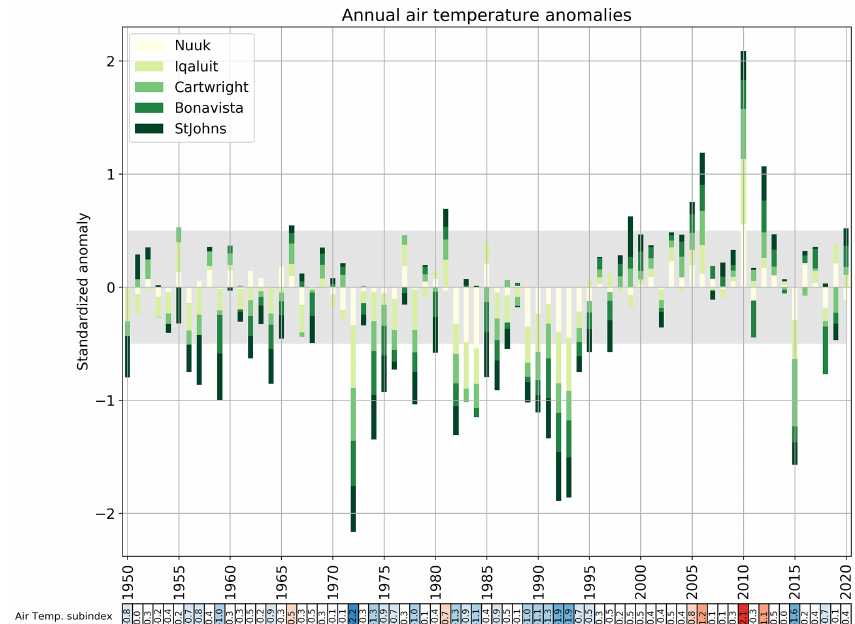
Figure 3. Normalized annual air temperature anomalies for Nuuk, Iqaluit, Cartwright, Bonavista and St. John’s. This figure shows the average of the five stations, in which the length of each bar corresponds to the relative contribution of the individual station to the average. The shaded area corresponds to the 1991–2020 average ± 0 . 5SD. The numerical values of this time series are reported in a colour-coded scorecard at the bottom of the figure. Positive anomalies ( > 0 . 5SD) are coloured red, while negative anomalies ( < − 0 . 5SD) are coloured blue. In both cases, the darker the colour, the stronger the anomaly. White corresponds to the climatological average ± 0 . 5SD. This time series is one component of the NL climate